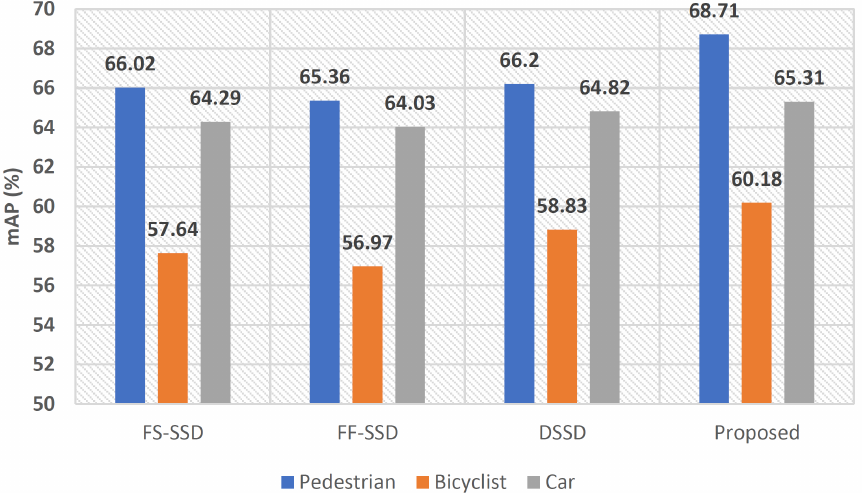
Figure 15. Comparison between the proposed model mAP with some other object detectors on the SDD dataset. Car, Bicyclist, and Pedestrian categories were considered in this comparison.